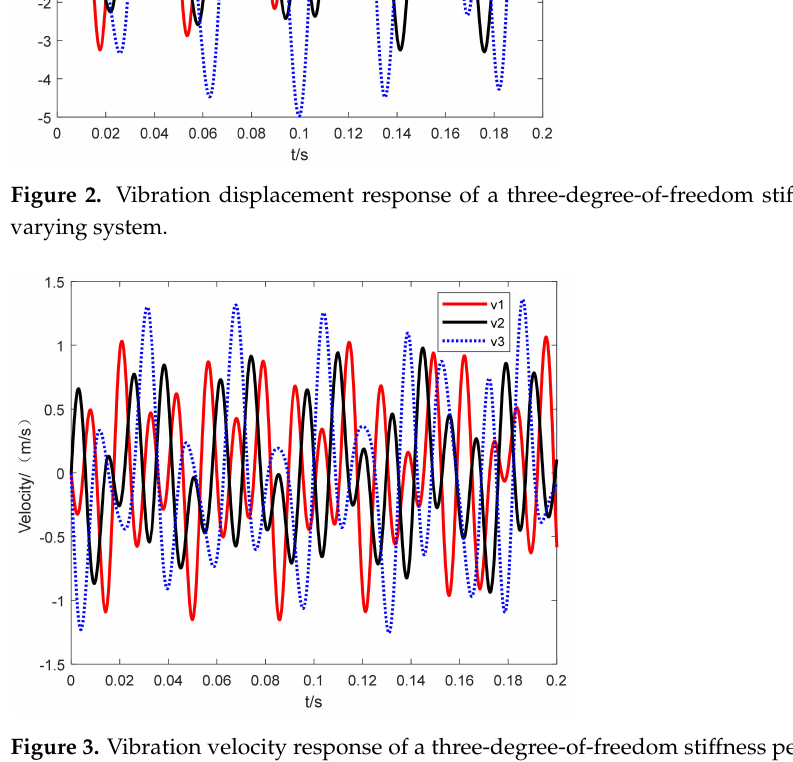
Figure 3. Vibration velocity response of a three-degree-of-freedom stiffness periodic time-varying system. Spectral analysis of the displacement signal is shown in Figure 4.